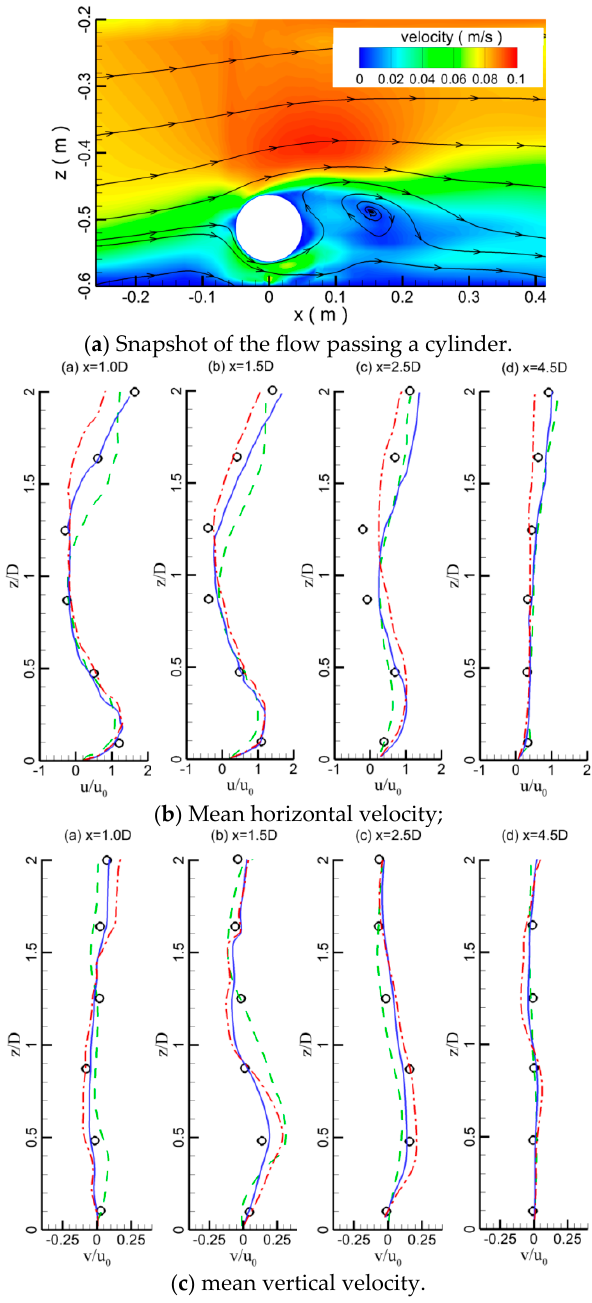
Figure 4. Simulation of the flow passing a cylinder. ( a ) Computed flow field near the cylinder. ( b ) Comparison of the horizontal velocity distribution. ( c ) Comparison of the vertical velocity distribution. Circle-measurement [28], green dash line, modeling with ĸ - ε turbulence closure [29], blue solid line, SIFOM, red dash-dot line, SIFOM–FVCOM.